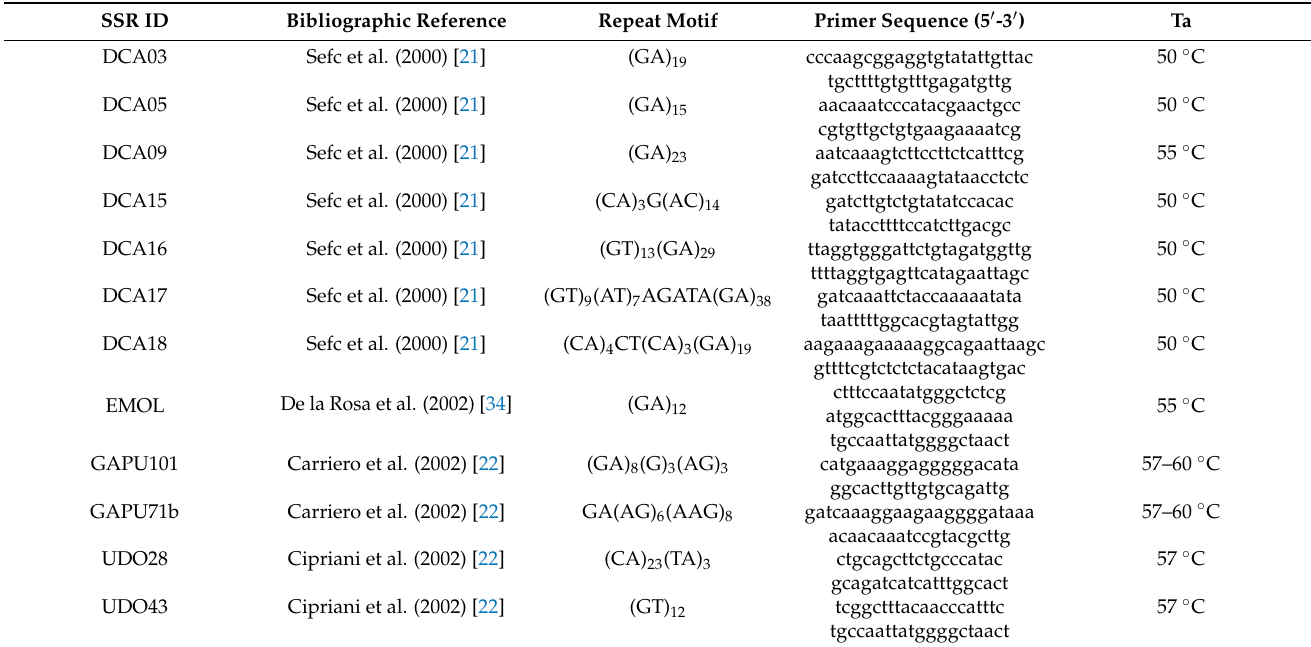
Table 1. List of the 9 microsatellite markers (SSR) used for routine genotyping of olive accessions. For each SSR, the identification code (SSR ID), bibliographic reference, repeat motif, primer sequence and annealing temperature (Ta) are reported.